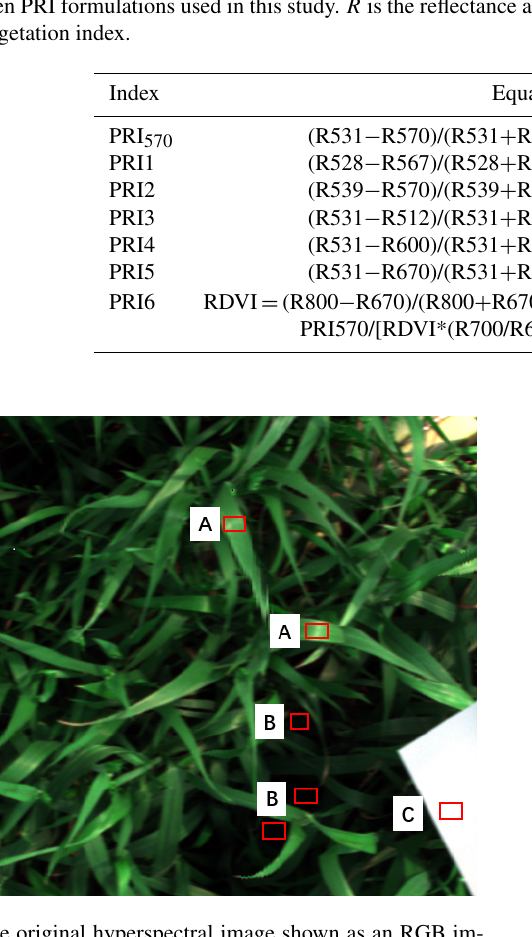
Figure 1. The original hyperspectral image shown as an RGB im- age. Region of interest (ROI) A is the sunlit leaves, ROI B is the shaded leaves, and ROI C is the reference spectral panel.